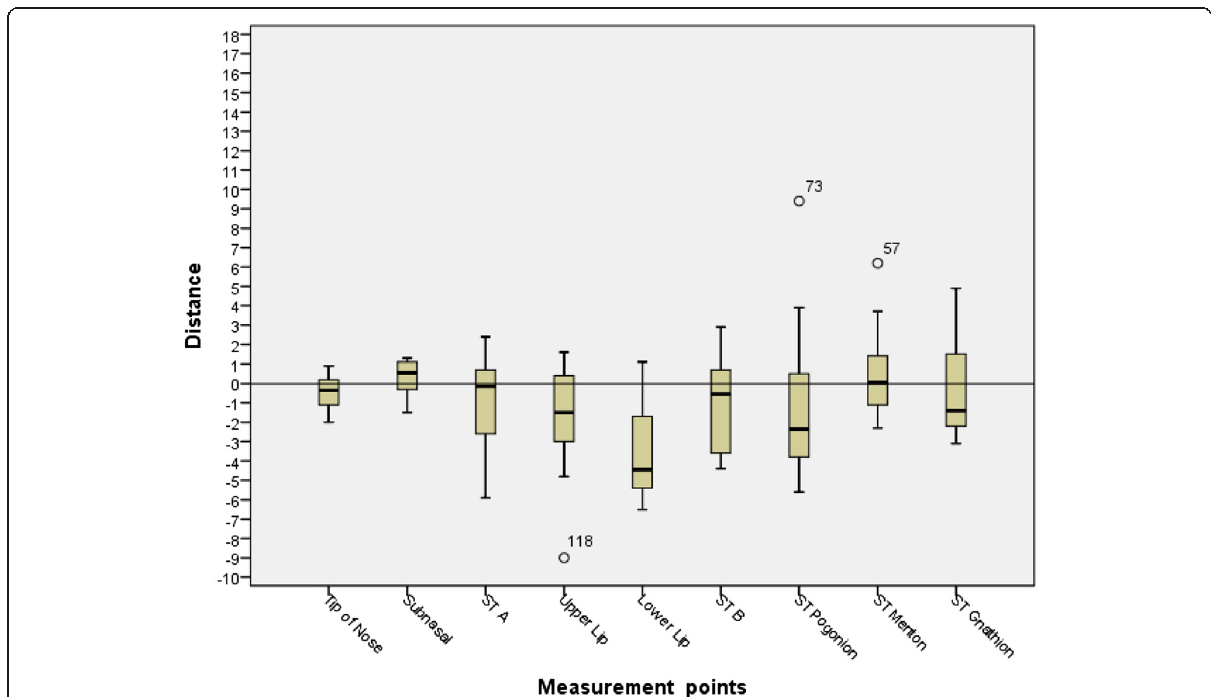
Fig. 5 Y -axis data